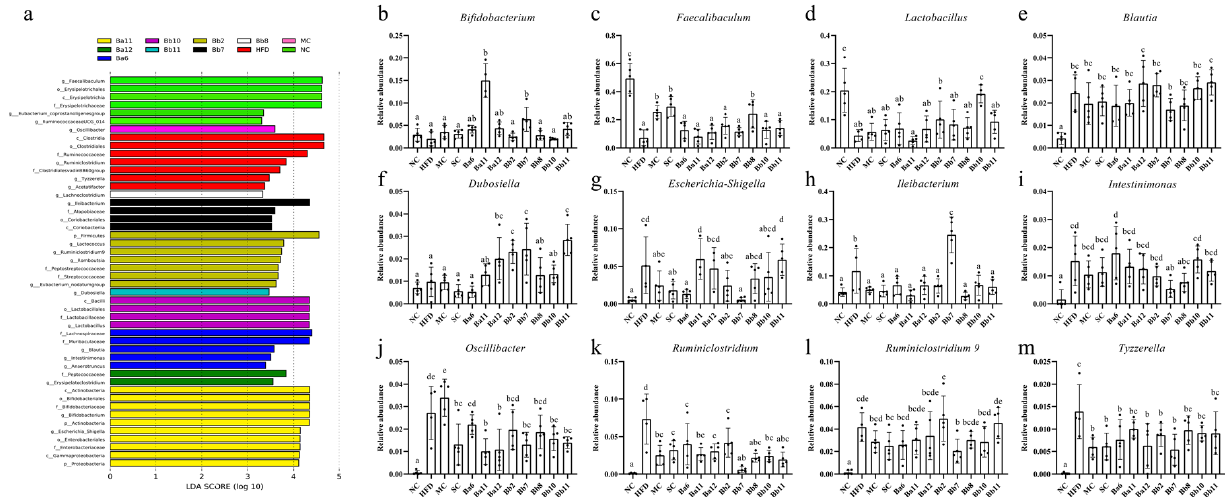
Figure 6. Effect of Bifidobacterium on intestinal microbiota of NAFLD mice. ( a ) the LEfSe analy- sis of gut microbiota after intervention with bifidobacteria in NAFLD mice; ( b ) Bifidobacterium ; ( c ) Faecalibaculum ; ( d ) Lactobacillus ; ( e ) Blautia ; ( f ) Dubosiella ; ( g ) Escherichia-Shigella ; ( h ) Ileibacterium ; ( i ) Intestinimonas ; ( j ) Oscillibacter ; ( k ) Ruminiclostridium ; ( l ) Ruminiclostridium 9 ; ( m ) Tyzzerella. Mean values with different letters (a–e) over the bars are significantly different ( p < 0.05) according to Duncan’s multiple range